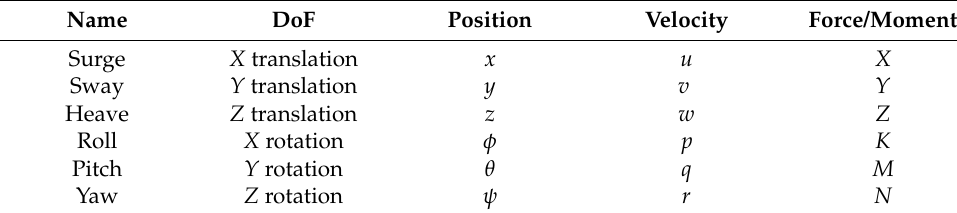
Table 1. Notation for vehicle dynamics according to SNAME.